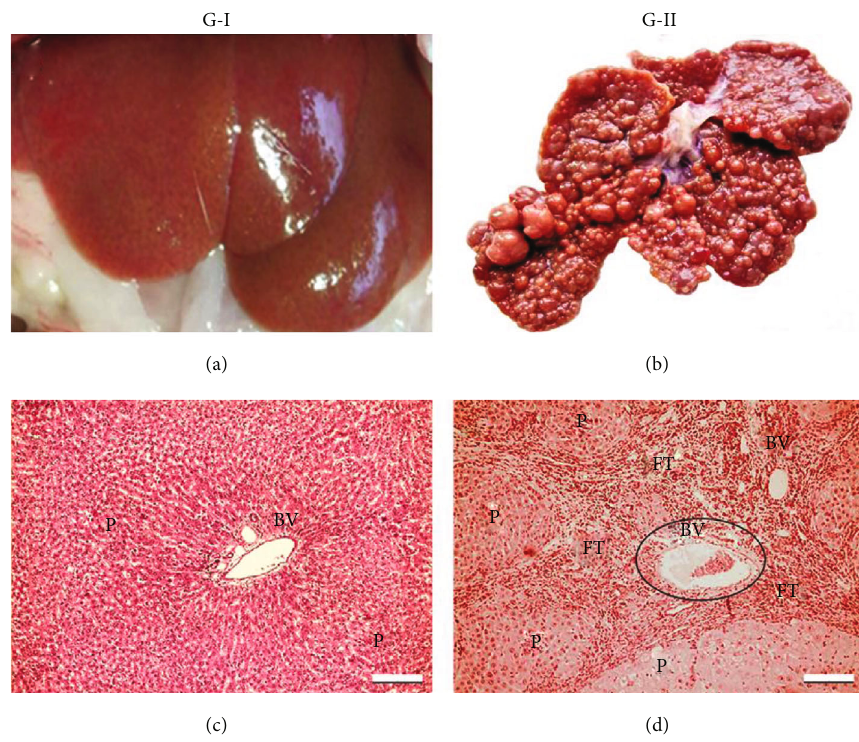
Figure 3: Representative photographs of liver histology. G-I control, (a) liver shows reddish brown colour, (c) without histological lesions. G-II treatment with TAA, (b) liver shows multinodular tissue, (d) increased fi brous tissue (blue arrows) and few areas of liver parenchyma. P: parenchyma; VS: blood vessel; TF: fi brous tissue, H&E. Bar length = 200 μ m . Table 1: Presence of nodules and weight of liver and spleen at necropsy according to experimental groups. Liver Spleen Groups Nodules Weight Weight Lesions Absence Regular Abundant Ma 1 Mi 2 (g) (g)